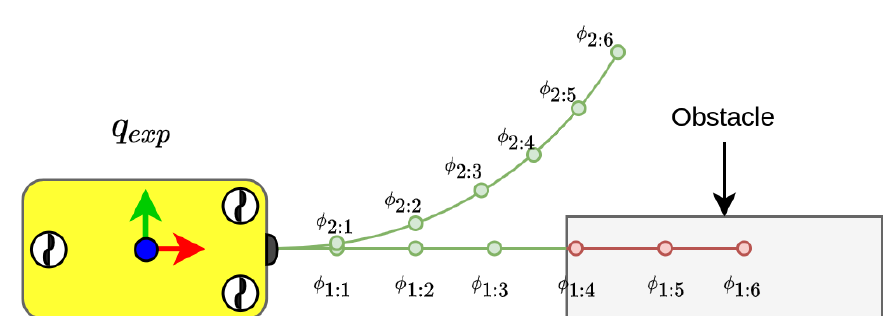
Figure 4. Incremental collision check is performed by traversing the intermediate states of a branch in the motion primitives until either the end state is reached (as in ψ 2:6 ) or a collision is found (as in ψ 1:4